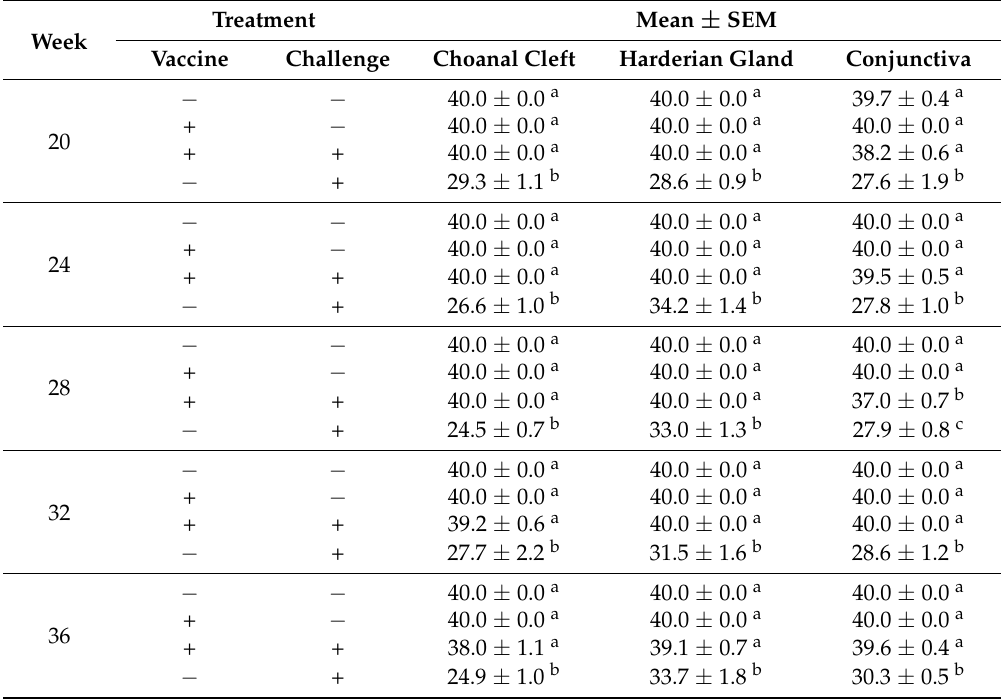
Table 3. Average qRT-PCR CT values for NDV RNA collected from choanal cleft, Harderian gland, and conjunctiva 5 days post-challenge with NDV B1 vaccine. Letters (a–c) indicate significant differences among vaccine and challenge groups for each week ( p <